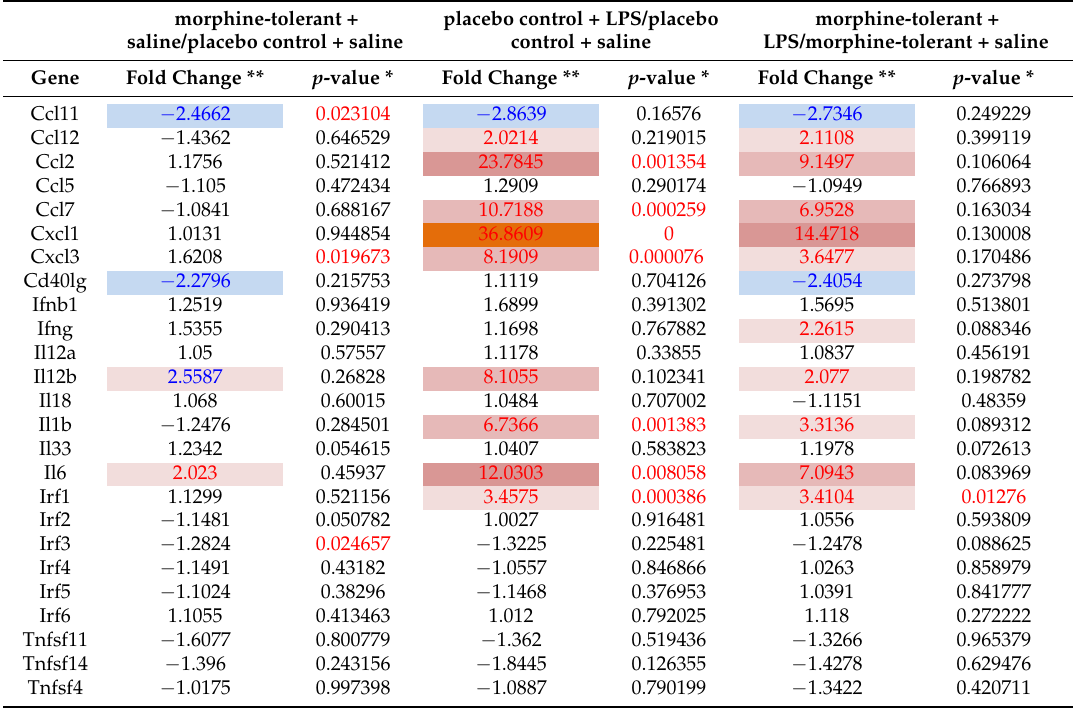
Table 3. Expression profile of the cytokine and chemokine genes in the rat brain in response to LPS, with and without morphine tolerance.